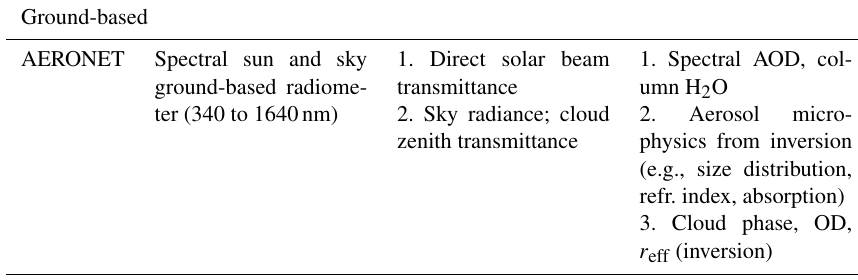
Table B3. Ground-based observations supported by